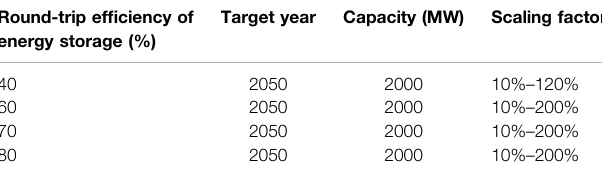
TABLE 5 | Summary of energy storage maximum bene fi t and duration for each round-trip ef fi